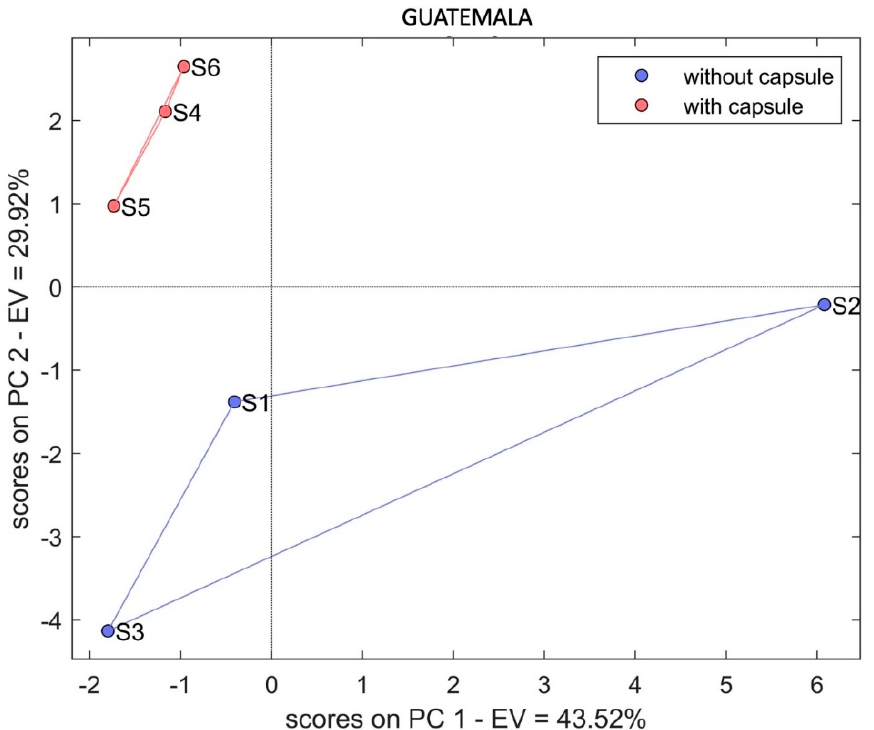
Figure 8. PCA score showing the comparison between volatile spectra compound of Guatemala coffee “with capsule” and “without capsule” exhibiting an EV (explained variance) = 73.44%.